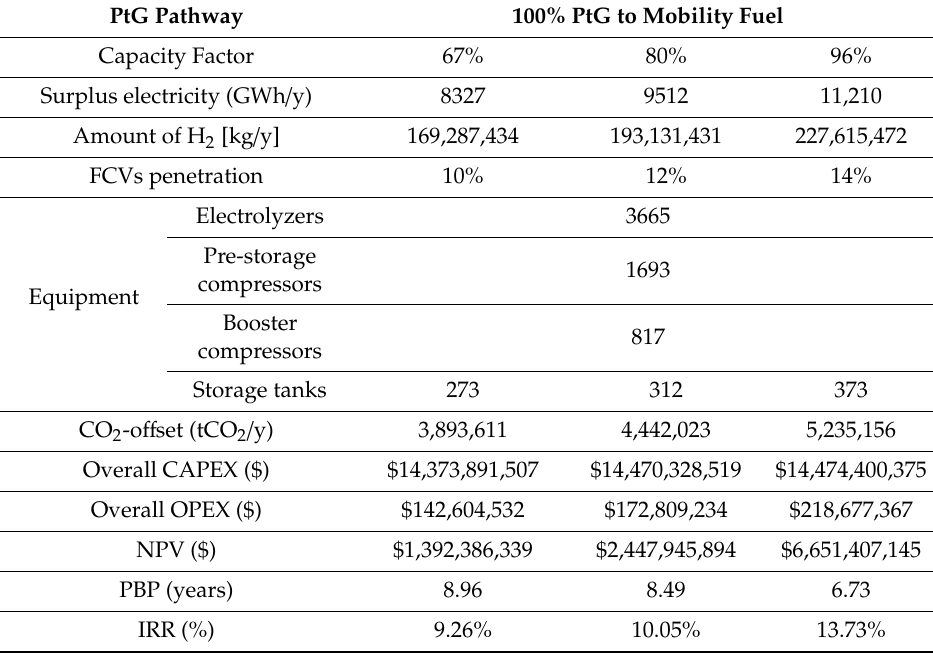
Table 8. Hydrogen allocation, Scenario B.